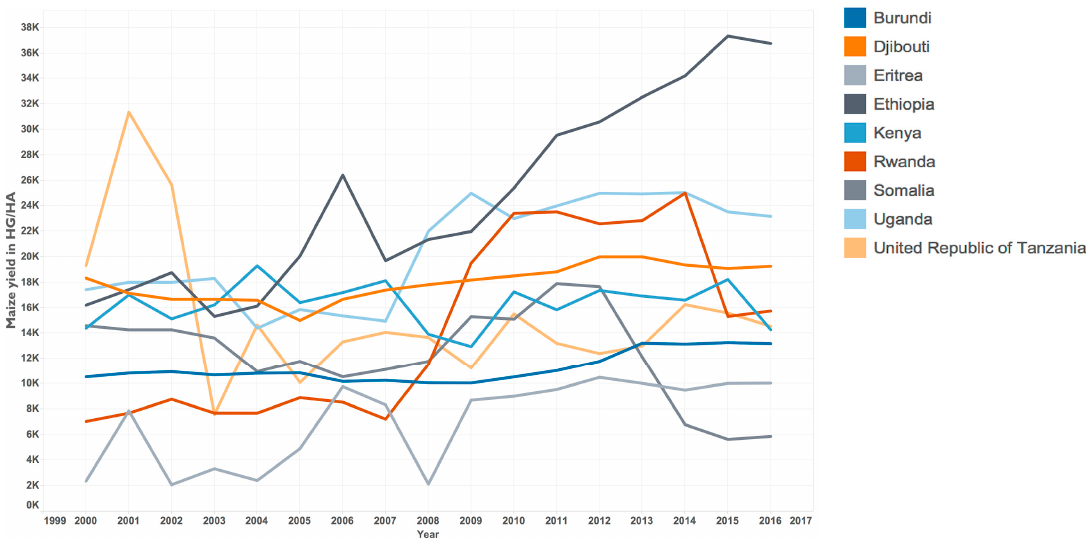
Figure 4. Annual national maize yield estimates in hectograms (100 grams) per hectare from FAOSTAT for 2000–2016.